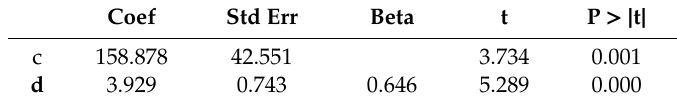
Coef Std Err Beta